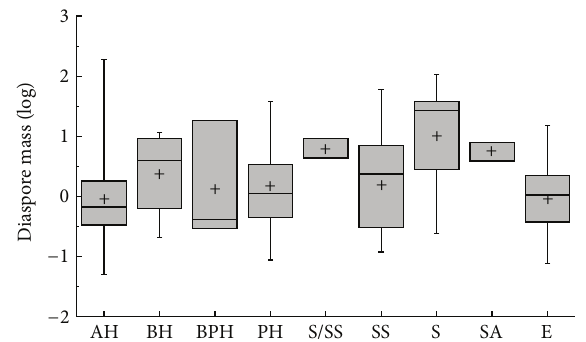
Figure 4: Box plots showing mean (+), median (—), quartiles, and outliers (-) of diaspore mass of 150 species grouped by different